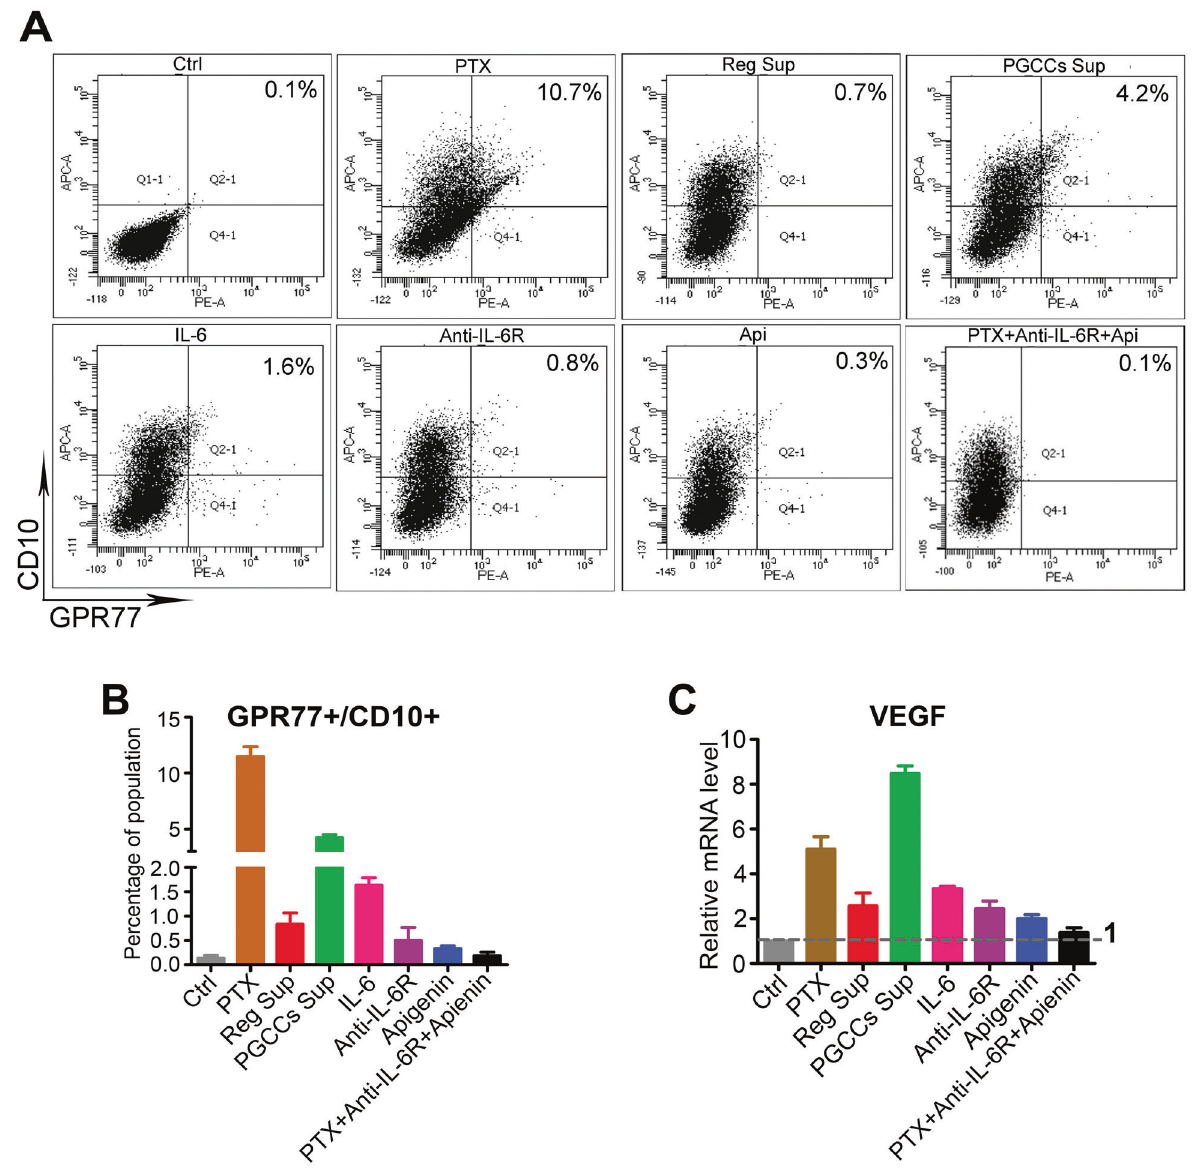
Fig. 5 PGCCs and IL-6 enriched the GPR77 + /CD10 + population and increased VEGF expression of fi broblasts. A , B GPR77 + /CD10 + population in fi broblasts increased signi fi cantly after treatment with paclitaxel (PTX; 11.5 ± 0.9%), PGCCs Sup (4.3 ± 0.3%), and IL-6 (1.6 ± 0.2%) compared with the control (0.1 ± 0.1%). C Expression of VEGF in fi broblasts was elevated signi fi cantly in the subgroups of PGCCs Sup (8.5 ± 0.4- fold), PTX (5.1 ± 0.6-fold), and IL-6 (3.3 ± 0.1-fold), respectively, which was inhibited by IL-6R antibody (2.4 ± 0.4-fold), apigenin (2.0 ± 0.2-fold), or combination (1.4 ±